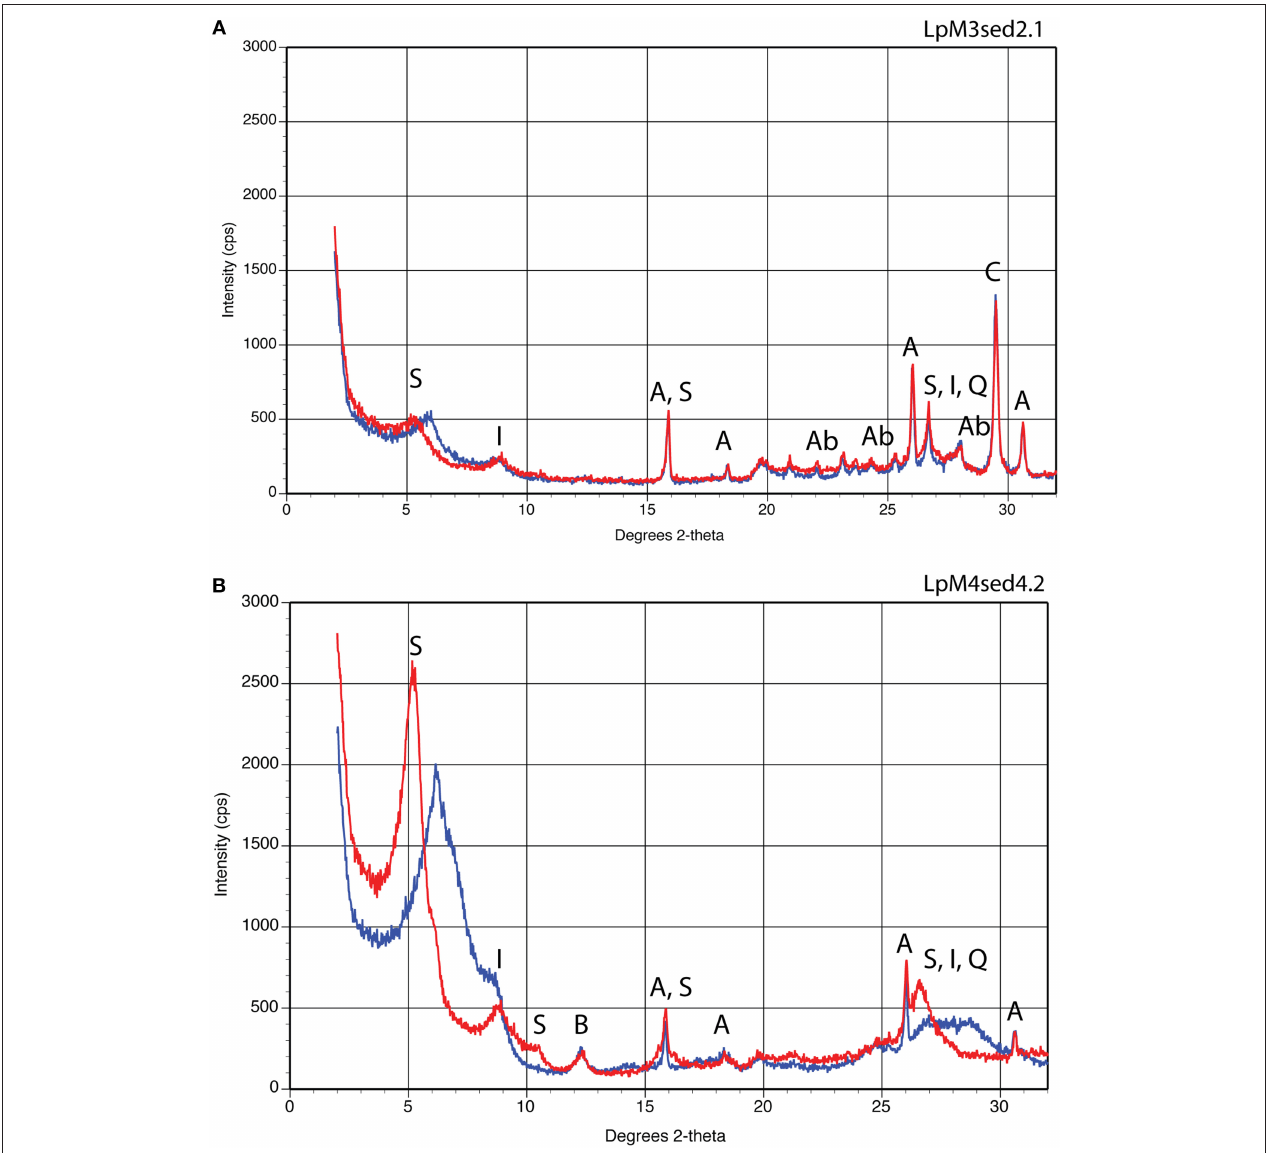
FIGURE 6 | X-ray diffraction results for sandstone (A) and silty claystone (B) facies. Blue line shows results under natural, air-dried conditions; red line shows results after 24h exposure to ethylene glycol. (A) Sample of sandstone from site LpM3. Peaks correspond to smectite (S), illite (I), analcime (A), albite (Ab), quartz (Q), and calcite (C). (B) Sample of silty claystone from site LpM4. Peaks correspond to smectite (S), illite (I), beidellite? (B), analcime (A), and quartz